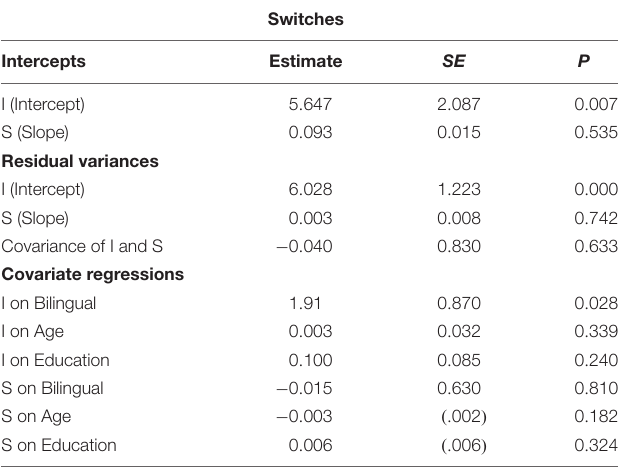
TABLE 5 | Estimates from the Conditional LGM modeling switches using biligualism, age, and education as covarietes.